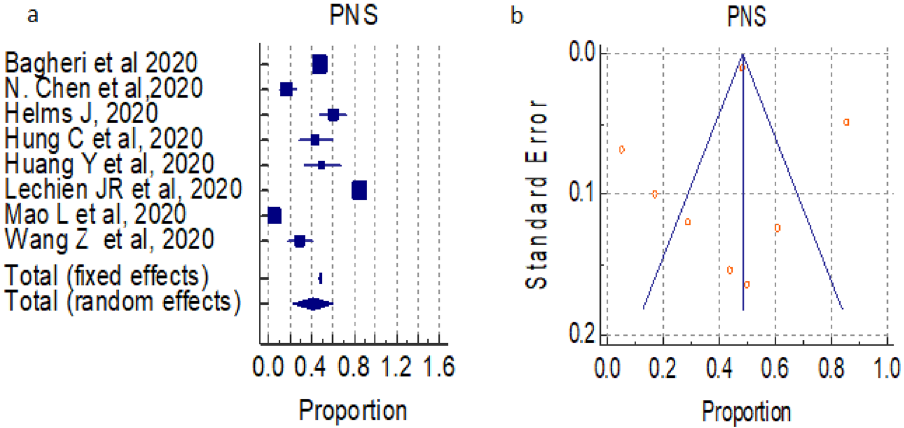
Figure 4. ( a ) Forest plot showed pooled prevalence of PNS complications among patients with COVID-19. ( b ) Funnel plot showed publication bias among studies evaluating neurological complications of COVID-19.